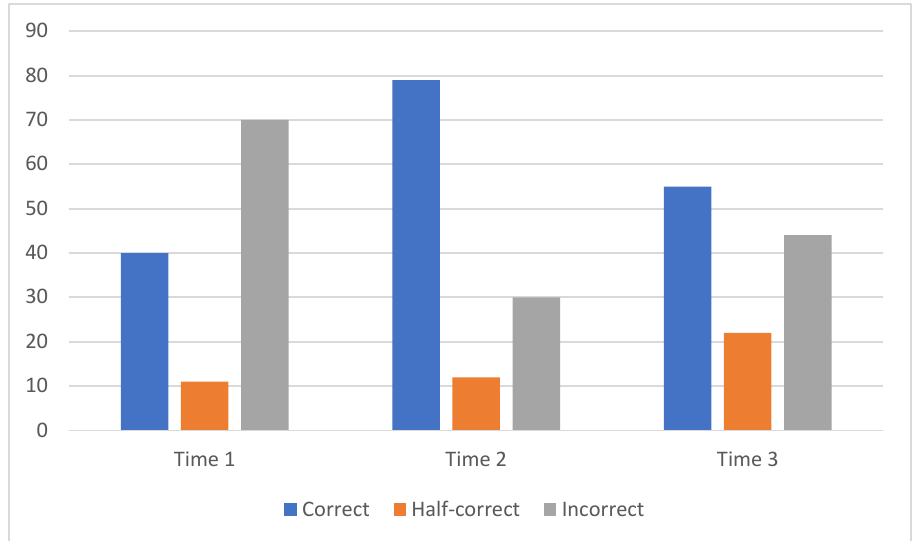
Figure 2 . Accuracy of definitions of a refugee at Times 1, 2, and